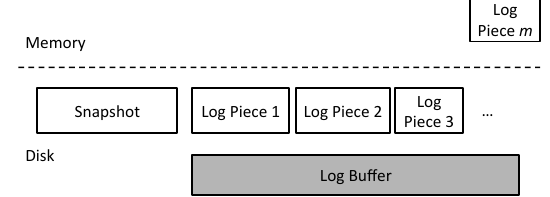
Fig. 4 Layout of a sealed chunk. Fields with asterisks are optional.